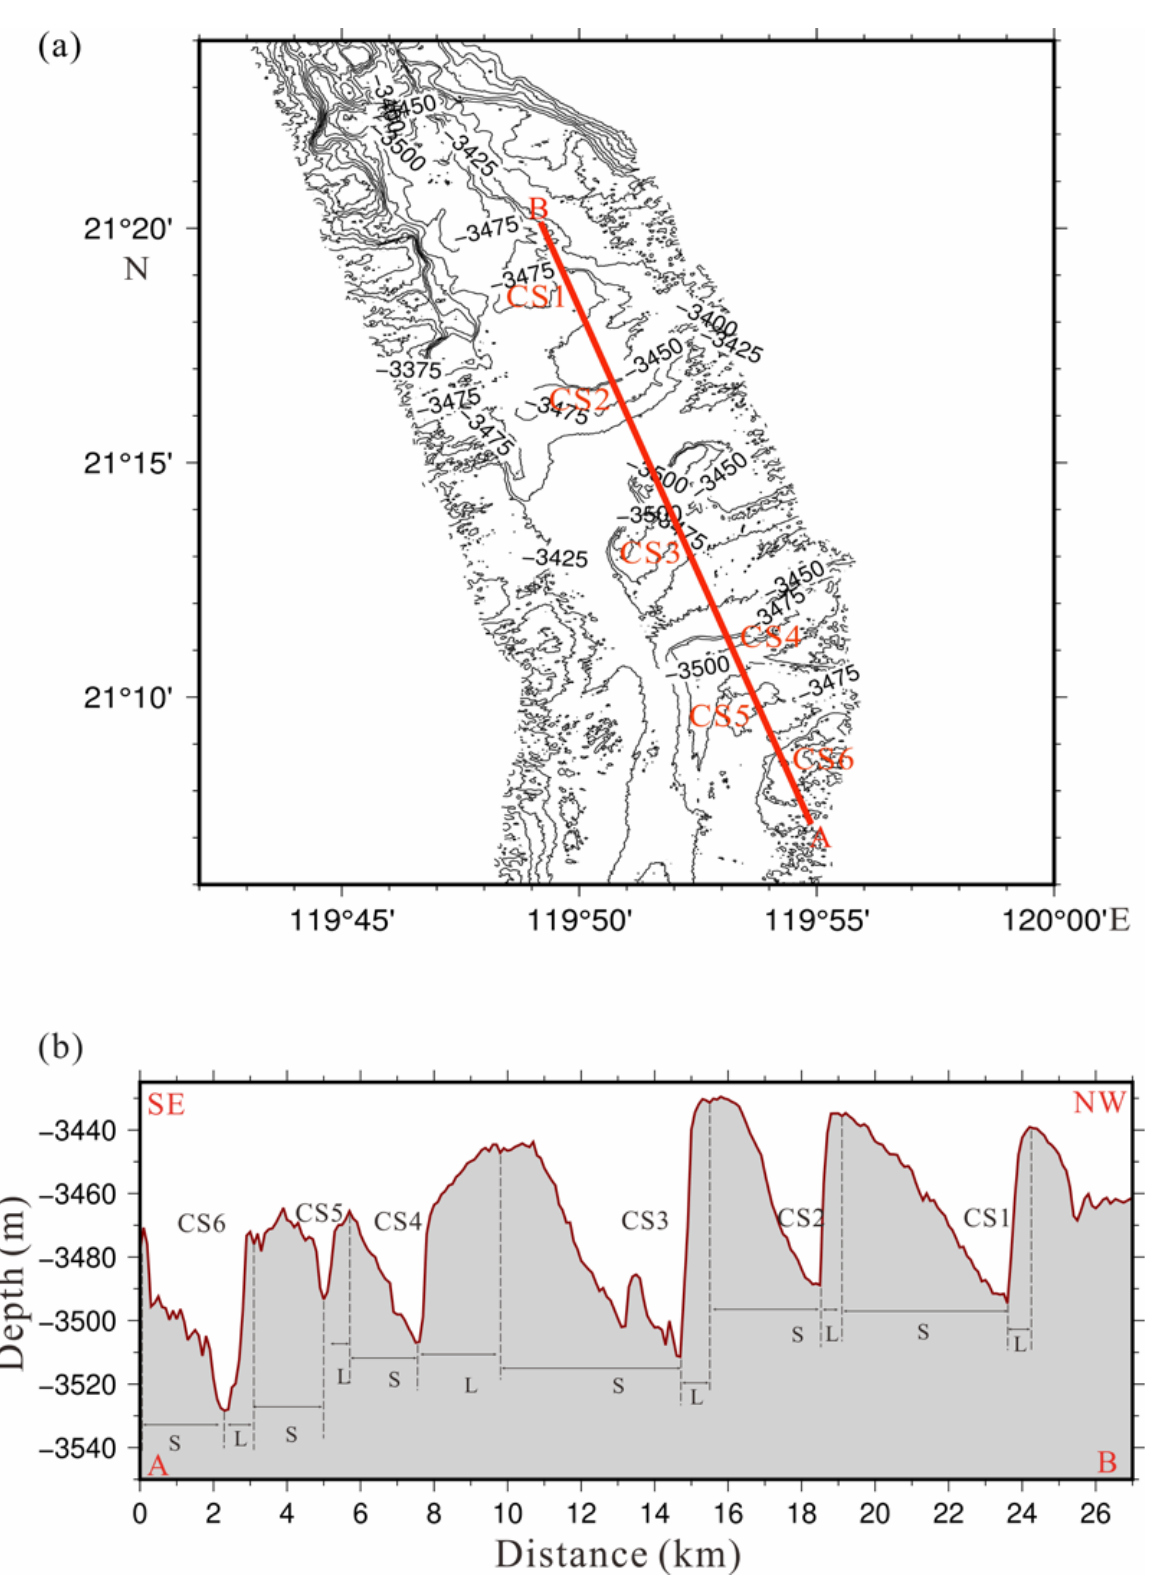
Figure 6. Contour map, and profiles across the cyclic step (CS1 − CS6) in the lower sections of the Penghu canyon. ( a ) Contour map of the CS1 − CS6 with contours at 50 m spacing. CS1 − CS6 show a closed pattern. The red line (AB) is the profile line. ( b ) Profile (AB) map of the CS1 − CS6. L-lee sides. S-stoss sides.